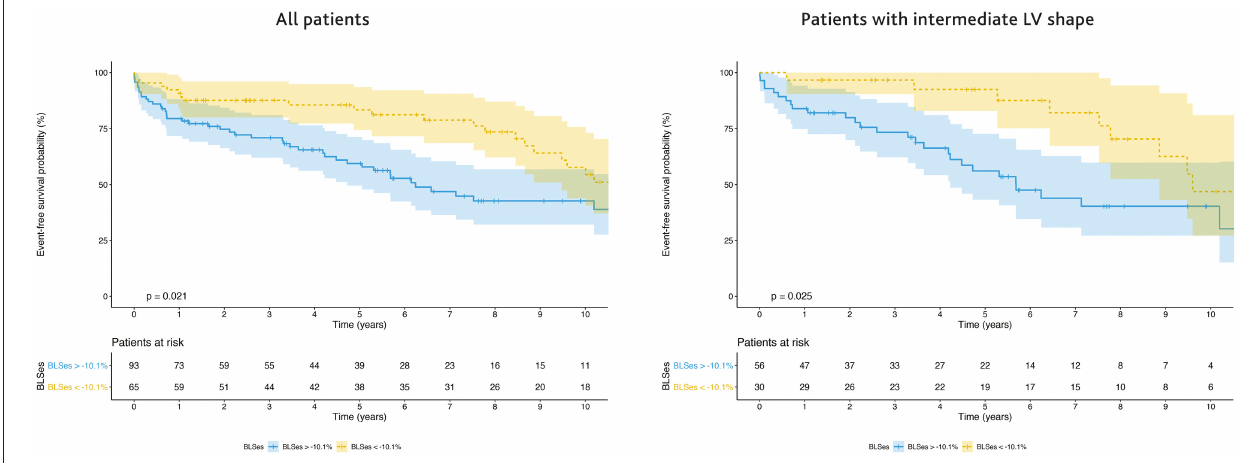
FIGURE 4 | Survival free from left ventricular assist device (LVAD) and heart transplantation according to BLS in the population as a whole (left panel) and in patients with an intermediate LV shape (right panel). The Kaplan-Meier survival curves are shown as a solid line with ticks indicating censor points; shadings represent 95% CI.